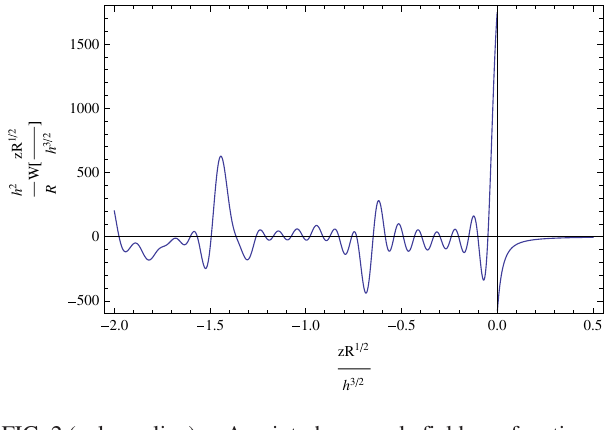
FIG. 2 (color online). A point-charge wakefield as a function of the dimensionless longitudinal position ˆ z for a square